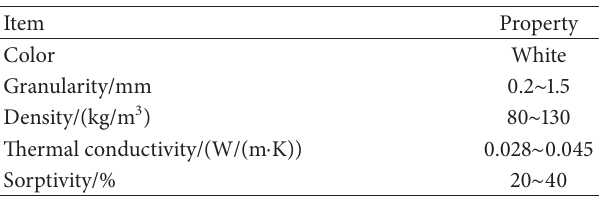
Table 1: Physical properties of